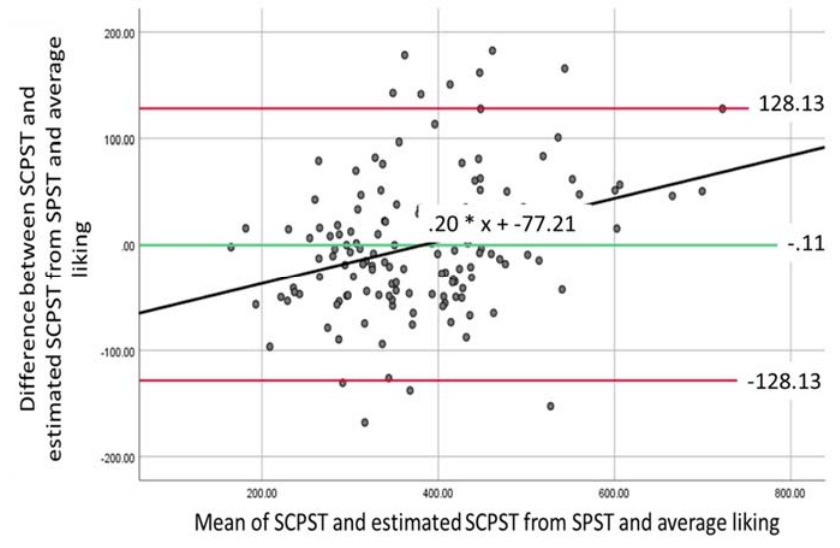
Figure 4. Bland–Altman plot for SCPST and SCPST estimate_SPST.